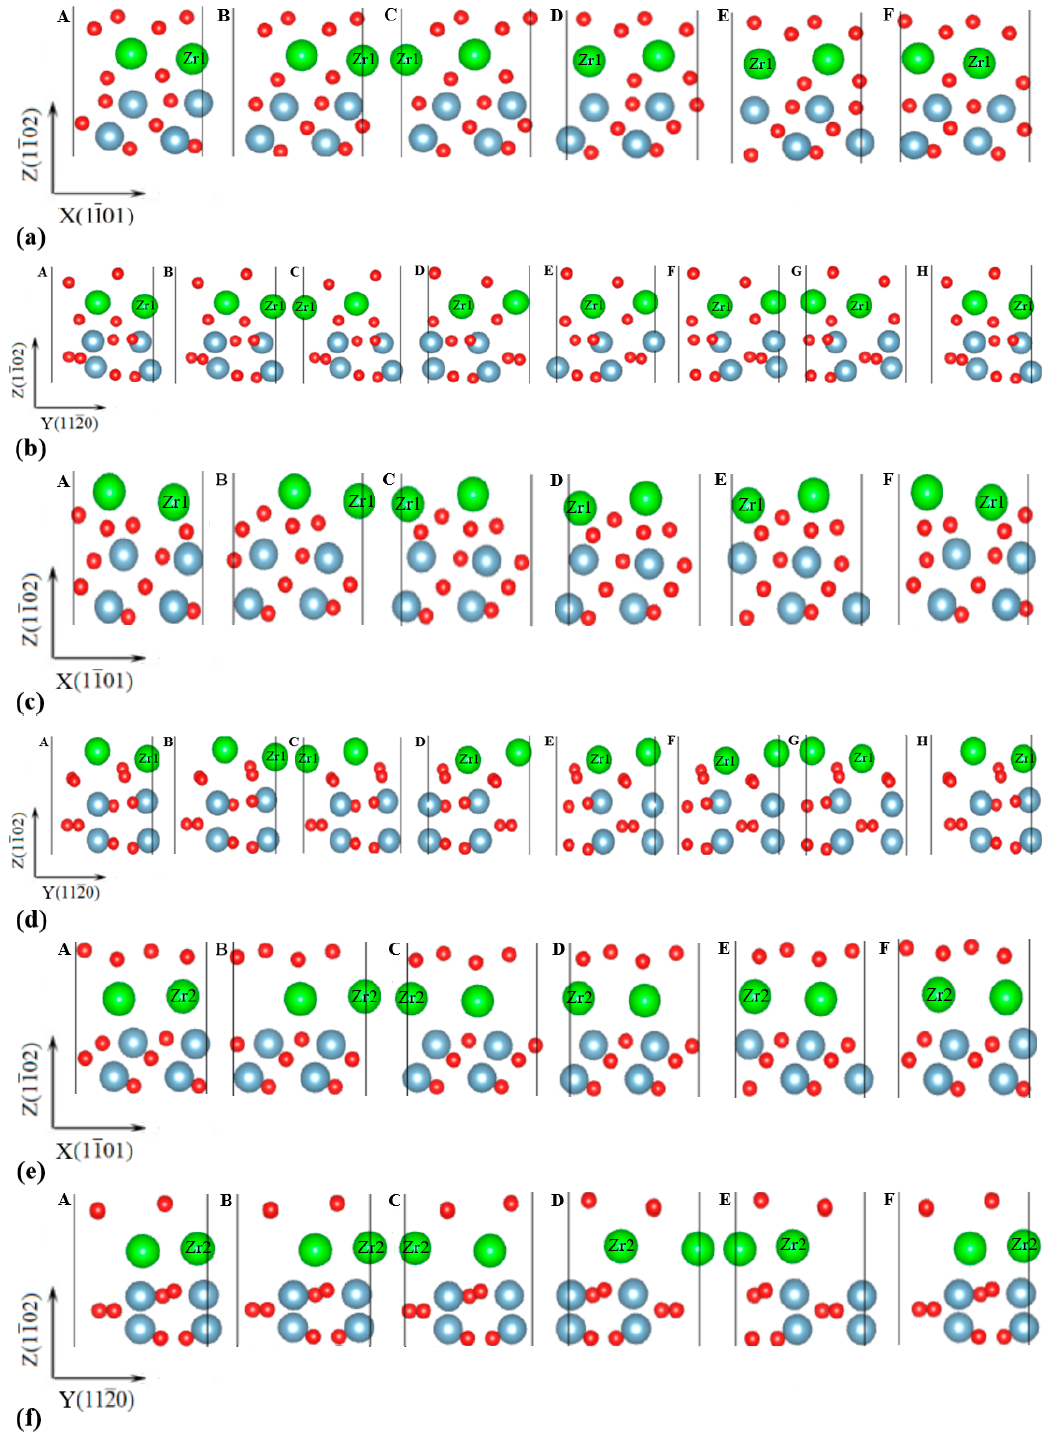
Figure 4. The evolution of the atomic structures at the c-ZrO 2 (001)/ α -Al 2 O 3 (11 (cid:3364) 02) interfaces during the shearing process: ( a ) O-<11 (cid:3364) 01>, ( b ) O-<112 (cid:3364) 0>, ( c ) 2O-<11 (cid:3364) 01>, ( d ) 2O-<112 (cid:3364) 0>, ( e ) Zr-<11 (cid:3364) 01>, and ( f ) Zr-<112 (cid:3364) 0>. The red, grey, and green spheres represent O, Al, and Zr atoms, respectively.